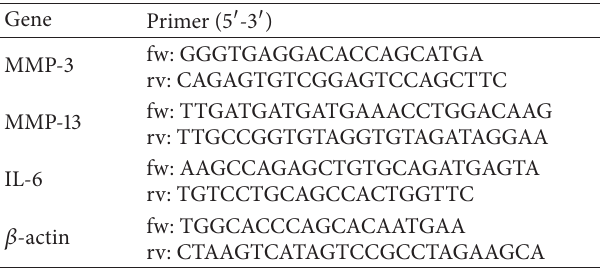
Table 1: Sequences of PCR